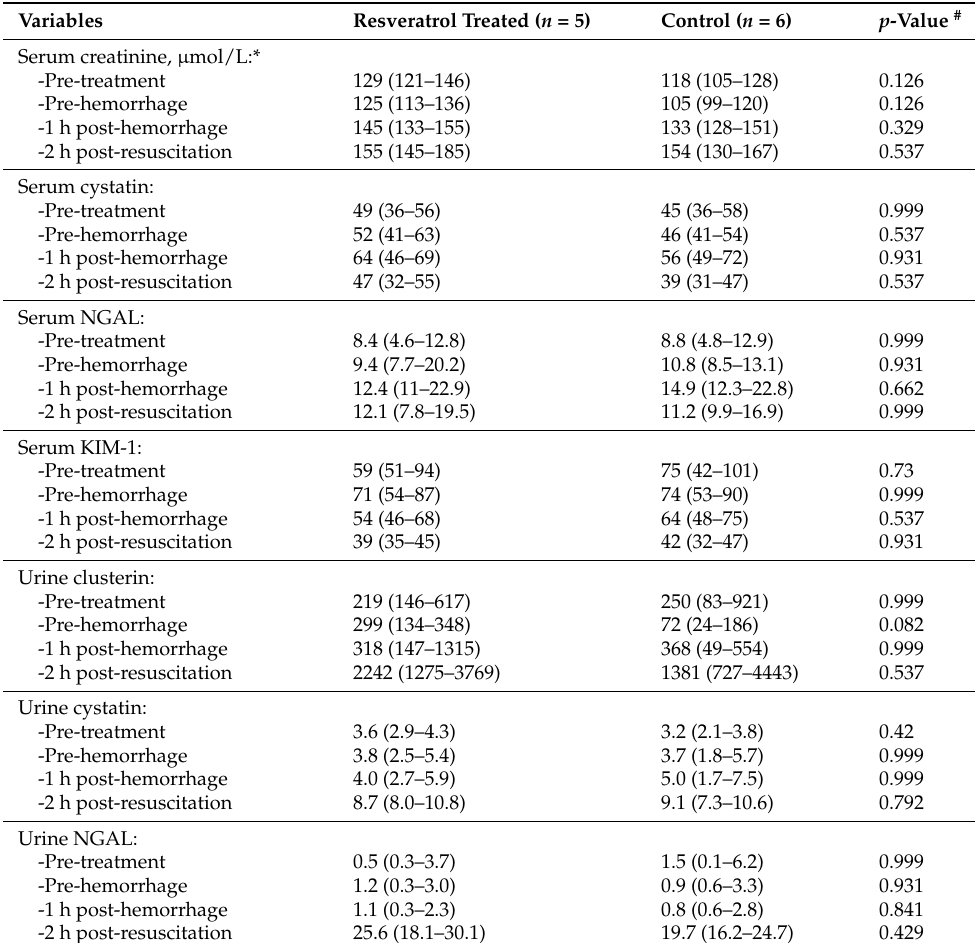
Table 2. Renal parameters of anesthetized greyhound dogs before and after induced hemorrhage ( n =